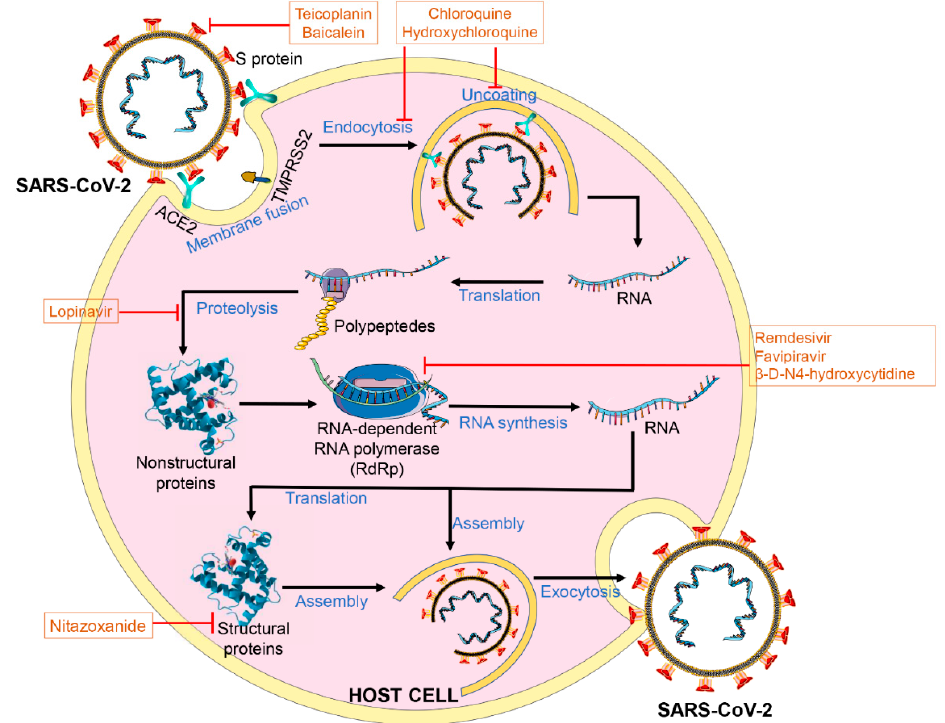
Figure 1. Schematic representation of severe acute respiratory syndrome coronavirus 2 (SARS-CoV-2) replication cycle within host cells. Proposed targets of the examined natural products, their derivatives and mimics are noted. ACE2, angiotensin-converting enzyme 2; S protein, spike protein; TMPRSS2, type 2 transmembrane serine protease, RdRp, RNA-dependent RNA